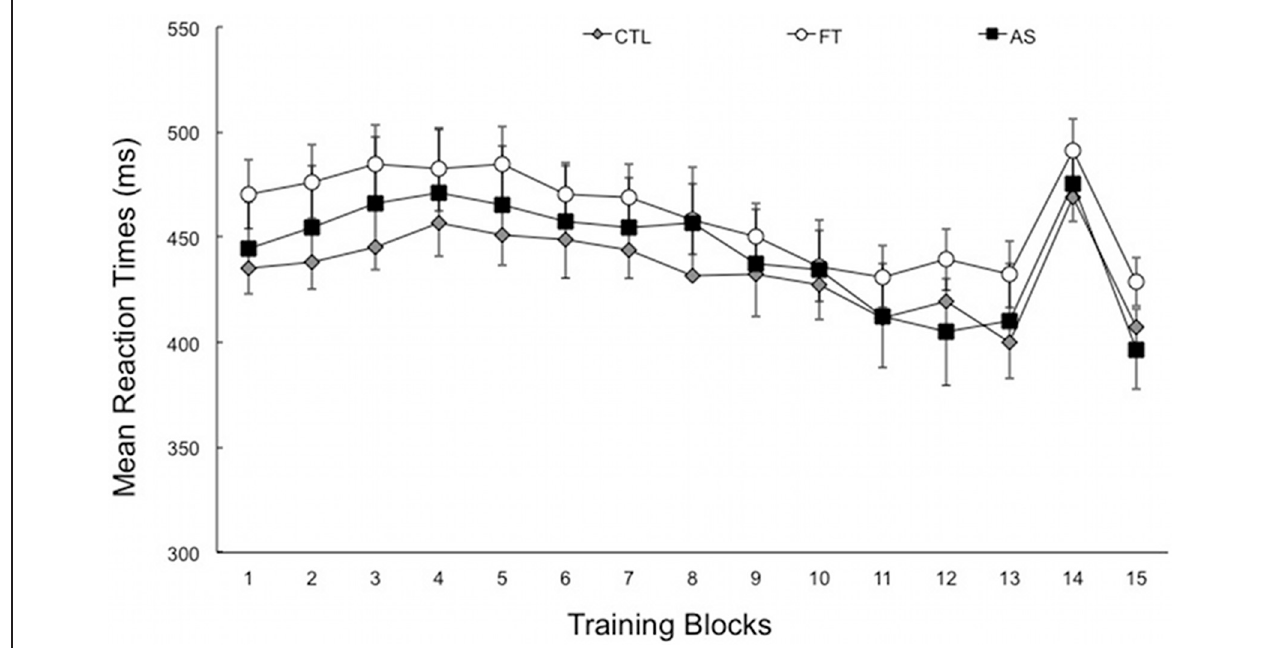
FIGURE 1 | Mean reaction times for each training block, plotted separately for the three conditions: articulatory suppression (AS), foot tapping (FT), and control (CTL) groups. Block 14 corresponds to the